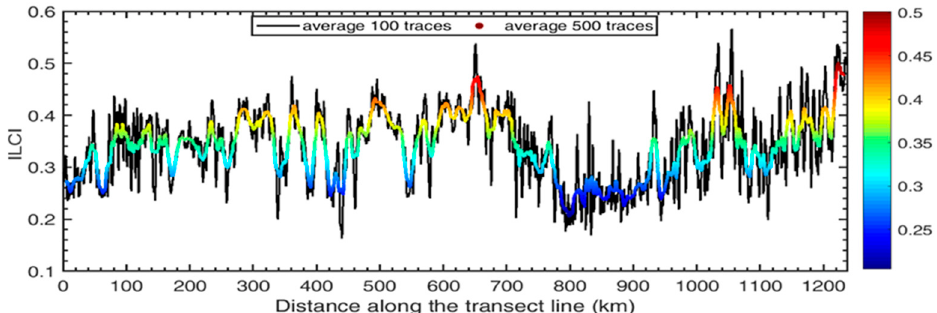
Figure 6. Internal layer continuity index (ILCI) graph of the airborne radar profile from Zhongshan Station to Dome A.